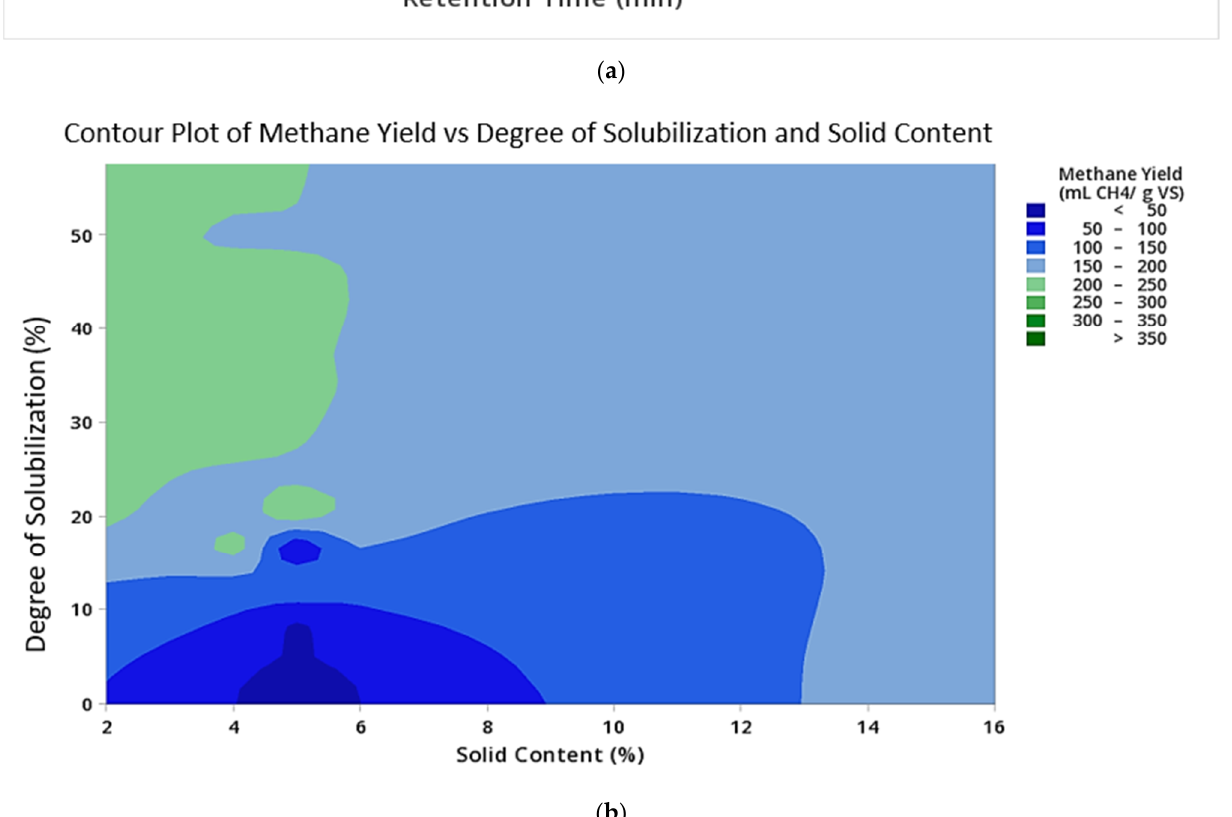
Figure 3. Contour plots for methane production, ( a ) methane yield vs. temperature and retention time, ( b ) methane yield vs. degree of solubilization and solid content.